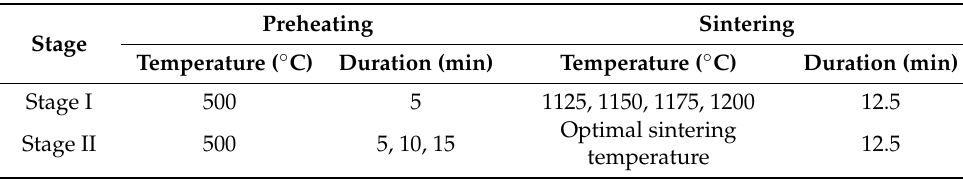
Table 1. S intering conditions for Stages I and II. Table 1. Sintering conditions for Stages I and II.